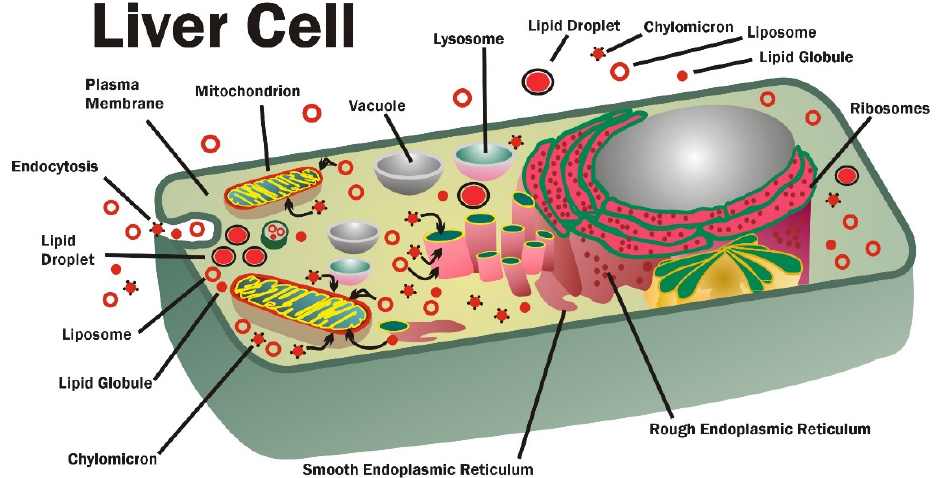
Figure 1. Some of the phospholipid transport systems involved in delivery of MLR phospholipids and other lipids to intracellular membranes and the reverse of this process. A liver cell is shown with internal lipid transport and storage systems, such as micelles, vesicles, globules, chylomicrons, and lipid droplets. These various lipid transport structures can bind to different intracellular membranes and transfer GPL and other lipids, and pick up damaged lipids for delivery outside of cells. Not shown in the figure are lipid transport/transfer by direct adjacent membrane-to-membrane contact and lipid droplet-, globule-, chylomicron- and vesicle-to-membrane contact or temporary fusion with adjacent intracellular membranes. Both the forward and reverse processes appear to be driven by mass action or bulk flow mechanisms. (Modified from Nicolson and Ash [1]).